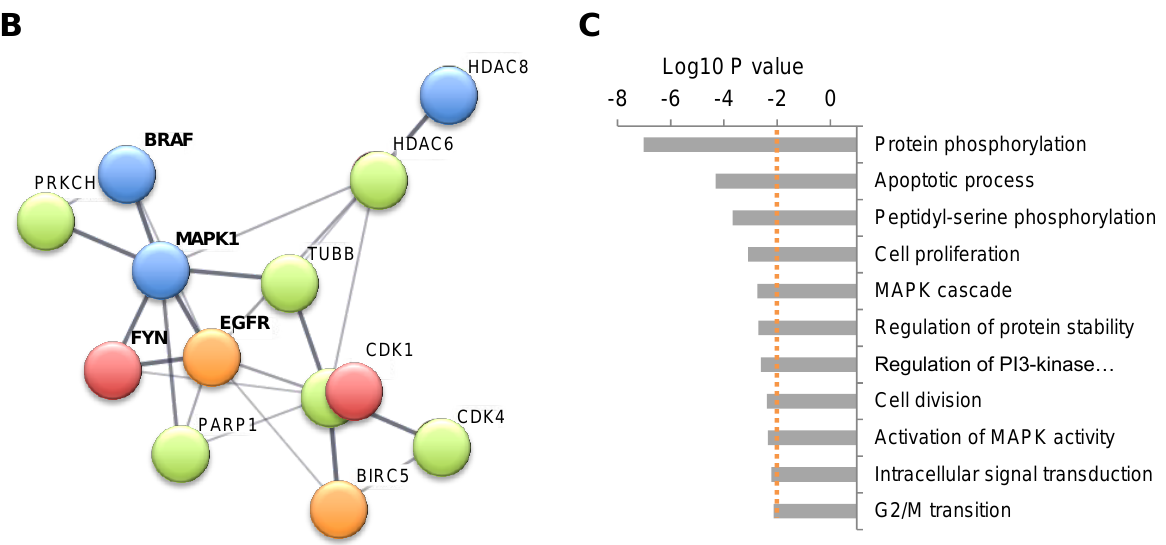
Figure 2. Involvement of oncogenic EGFR pathway due to pevonedistat treatment in CR(C). ( A ) IPA was performed on the 17 hit genes to analyze their involvement in functional networks. In the three networks emerged from the analysis, candidate genes are highlighted by colors representing the screening cell line of origin. ( B ) Gene interaction network generated by STRING, including 12 of the 17 candidates. Line thickness represents strength of data confidence (interaction score > 0.400). Color nodes as above. ( C ) Result of Gene Ontology biological processes (GO-BP) analysis performed with DAVID on the hit genes. Representative biological functions are reported and ranked by LOG 10 p -value (for a complete list of significant functions, see Table